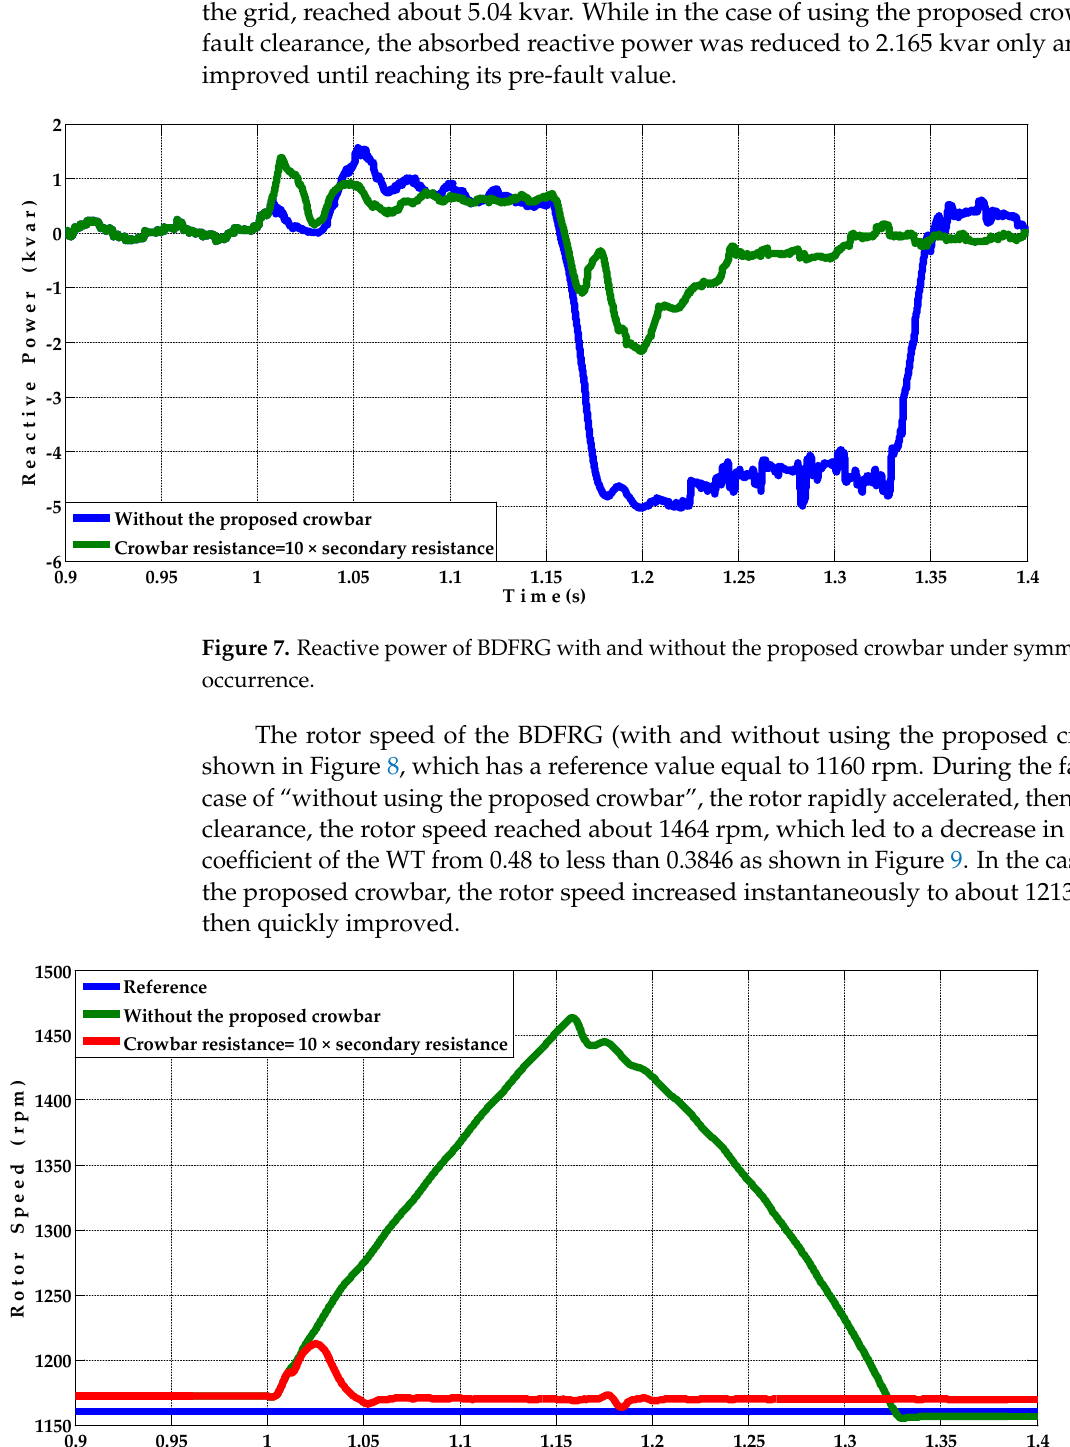
Figure 6. Active power of BDFRG with and without the proposed crowbar under symmetrical fault occurrence.